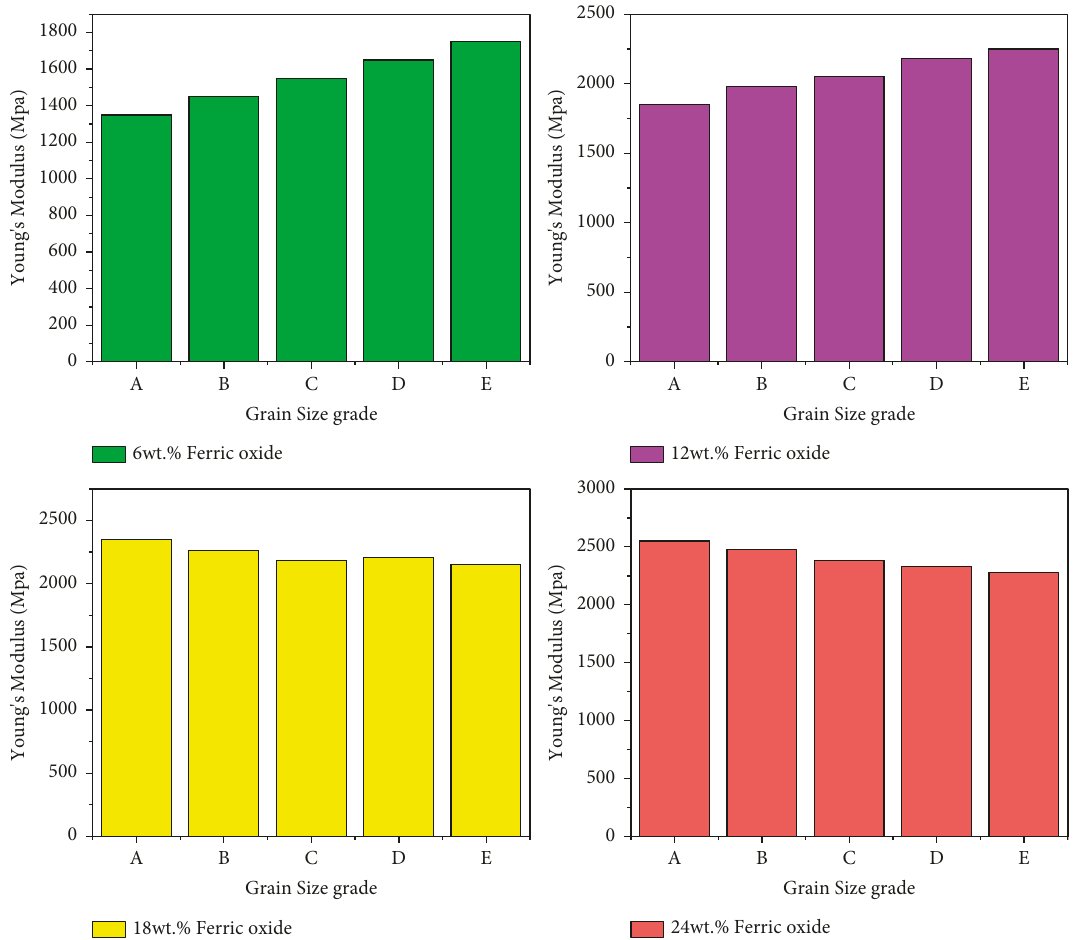
Figure 4: Effect of various weight fractions and ferric oxide particle size in Young’s modulus of polyethylene/ferric oxide composites.